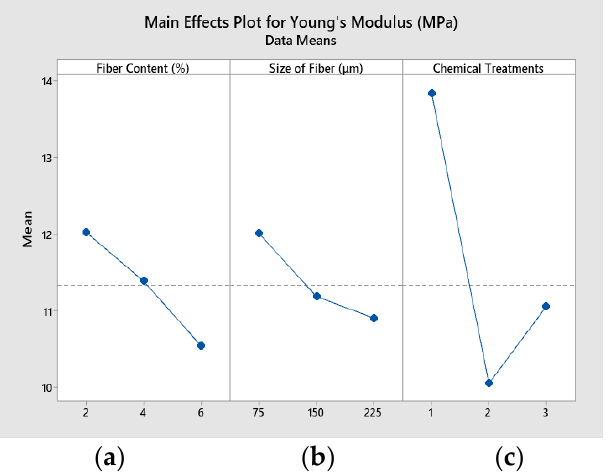
Figure 11. M ain effects plot for Young’s modulus. ( a ) fiber content (%) ( b )size of fiber ( c ) chemical Figure 11. MaineffectsplotforYoung’smodulus. ( a )fibercontent(%)( b )sizeoffiber( c treatments.